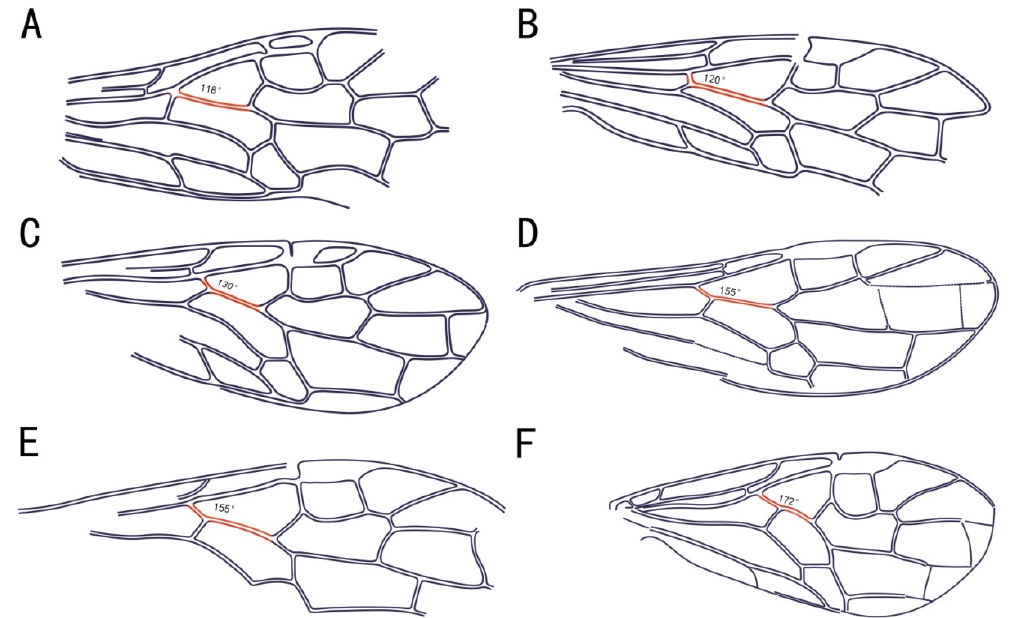
Figure 3. Angle of Rs+M and the section of Rs in the subfamily Macroxyelinae. ( A ), Uroxyela sicicauda , Rasnitsyn, 1966 (Xyeleciini). ( B ), Ceroxyela dolichocera , Rasnitsyn, 1966 (Ceroxyelini). ( C ), Leptoxyela eximia , gen. et sp. nov (Angaridyelini). ( D ), Megaxyela yaoshanica , Zhang, 1989 (Macroxyelini). ( E ), Sinoxyela viriosa , Zhang and Zhang, 2000 (tribe to be determined). ( F ), Abrotoxyela multiciliata , Gao, Ren and Shih, 2009 (Gigantoxyelini).